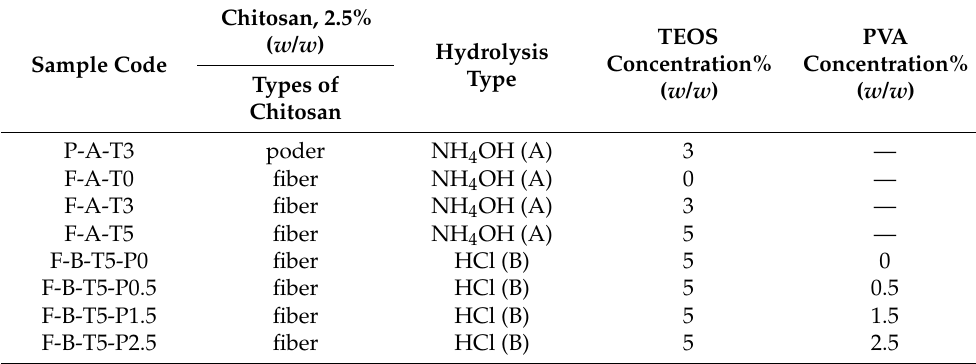
Table 1. Composite scaffolds